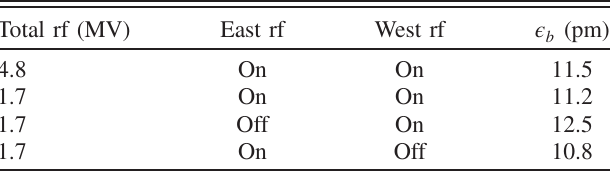
TABLE VI. Summary of beam stability tests at CesrTA. The measurements were conducted in April 2013, for a single bunch of positrons at 0.7 – 0.85 mA.